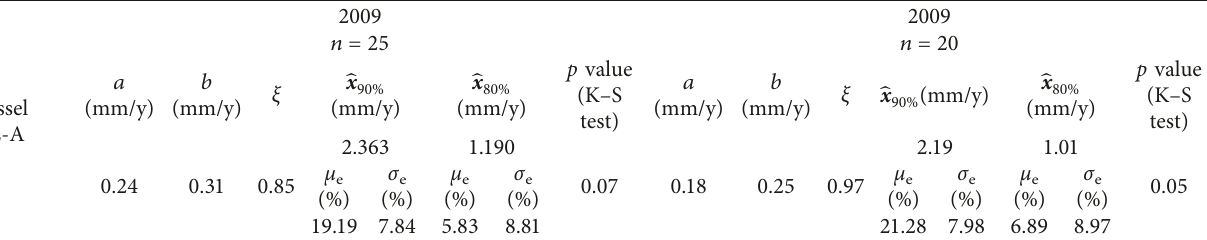
Table 3: GEV distribution parameters for HE-A with different numbers of sampling units ( n � 25 and n � 20) in 2009 and its corre- spondence error in comparison with the observed data.